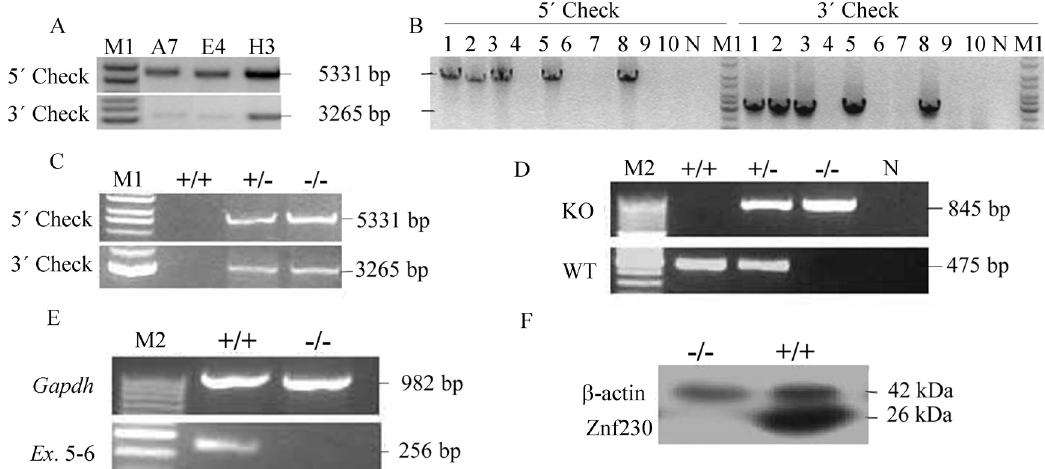
Figure 2 - The generation and identification of Znf230 KO mice. (A) L-PCR analysis using primer pairs P1F/P1R and P2F/P2R to amplify the targeted Znf230 allelesfromgenomicDNAextractedfromESCs.ESCsfromNo.A7,E4andH3werethepositiveclonesundergoingtargetedhomologousrecom- bination. (B) L-PCR analysis of the targeted Znf230 alleles amplified from genomic DNA derived from the offspring of chimeric mice backcrossed to C57BL/6J. No. 1-10: the offspring members and N: negative control. (C) L-PCR analysis to monitor the inheritance of the targeted Znf230 allele in the progeny of heterozygous Znf230 KO mice. (D) PCR analysis to monitor the inheritance of the targeted Znf230 allele in the progeny of heterozygous Znf230 KO mice using primer pairs WTf/WTr and Nf/Nr. (E) RT-PCR analysis of the Znf230 gene in testes from Znf230 KO and C57BL/6J mice. M1, M2: DNA ladders of 1 kb and 100 bp, respectively. Gapdh was used as an internal control. (F) Western blot analysis of the Znf230 protein in the testes from Znf230 KO and C57BL/6J mice. (cid:4) -actin was used as an internal